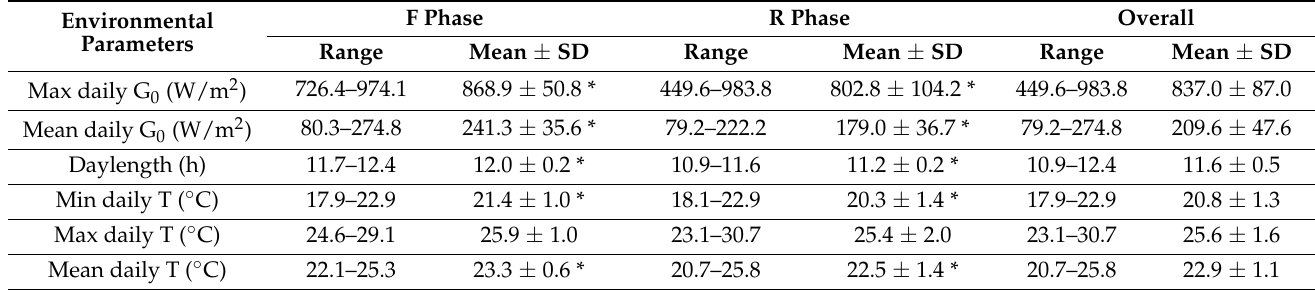
Table A1. Summary of the environmental parameters of maximal and mean global horizontal solar irradiation, day length, and minimal, maximal and mean ambient temperature daily recorded outside the greenhouse. The values are presented as range and mean ± SD for each experimental phase (i.e., F phase: 12 Sep. to 11 Oct., and R phase: 11 Oct. to 11 Nov.) and for the whole cultivation period (Overall: 12 Sep.–11